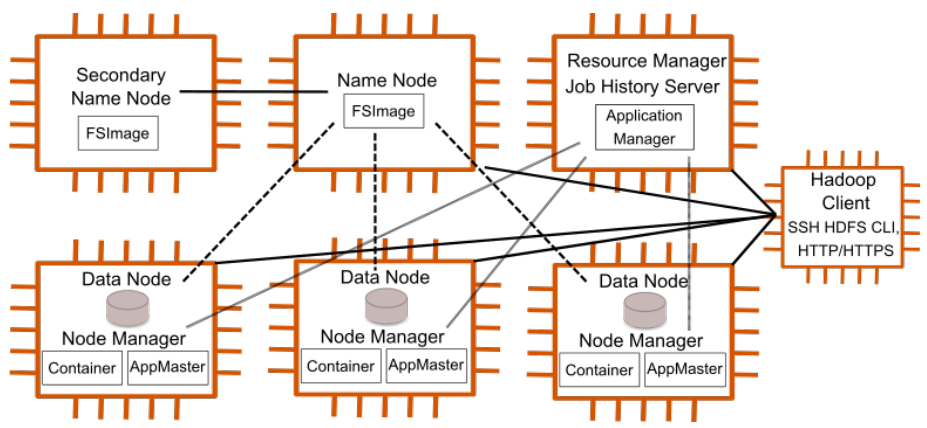
Figure 1. HDFS, YARN, and the Hadoop client component interfaces. Solid lines indicate data and job exchanges during program execution and dashed lines indicate FSImage information exchange.